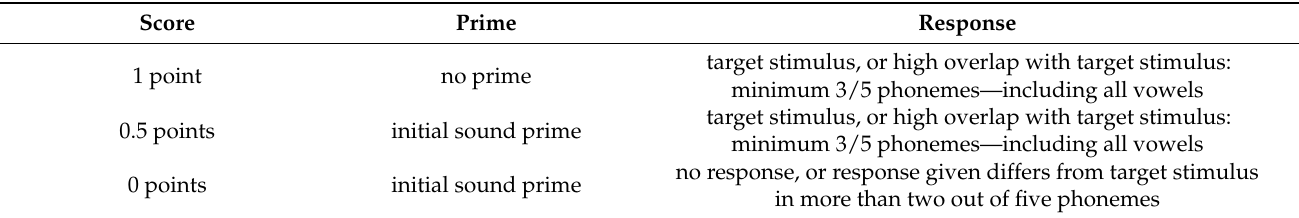
Table A3. Scoring system of children’s responses in the DNWL naming